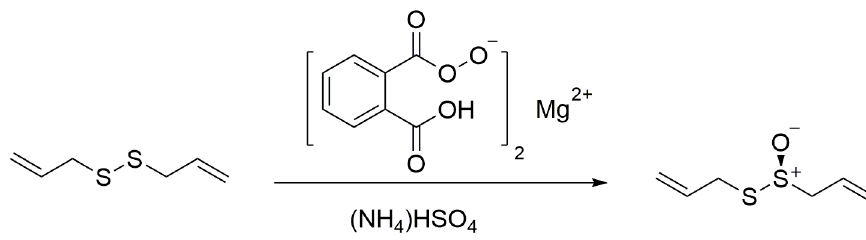
Figure 1. Synthesis of allicin.